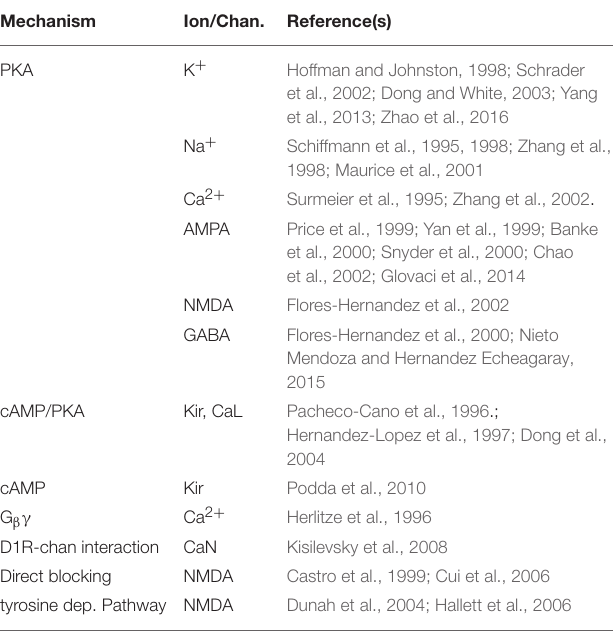
TABLE 5 | Summary of studies reporting mechanism of DA modulation.